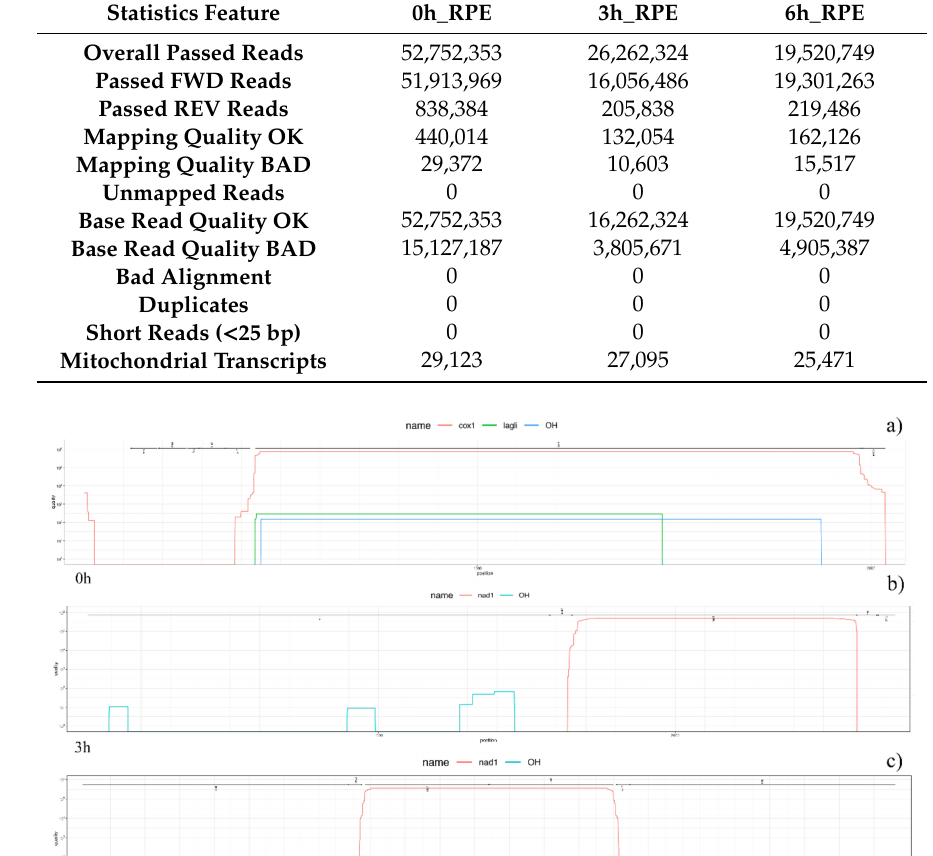
Table 1. Alignment and assembly statistics of RNA-Seq analyzed samples. Table shows main features related to mitochondrial transcripts shared in overall RNA, as well as mapping and assembly steps performed on RNA-Seq samples by CLC Genomics Workbench, SMART2 and TRIMITOMICS algorithms. Values are reported as the mean of the three algorithms and of all three biological replicates for each sample.